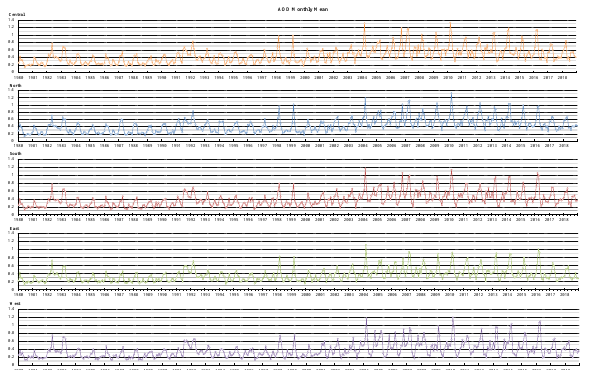
Figure 2. Monthly AOD trend after calculating the average of the AOD grids that form the comparing group, from top to bottom are the monthly AOD trend of Central, North, South, East and West of GDHM